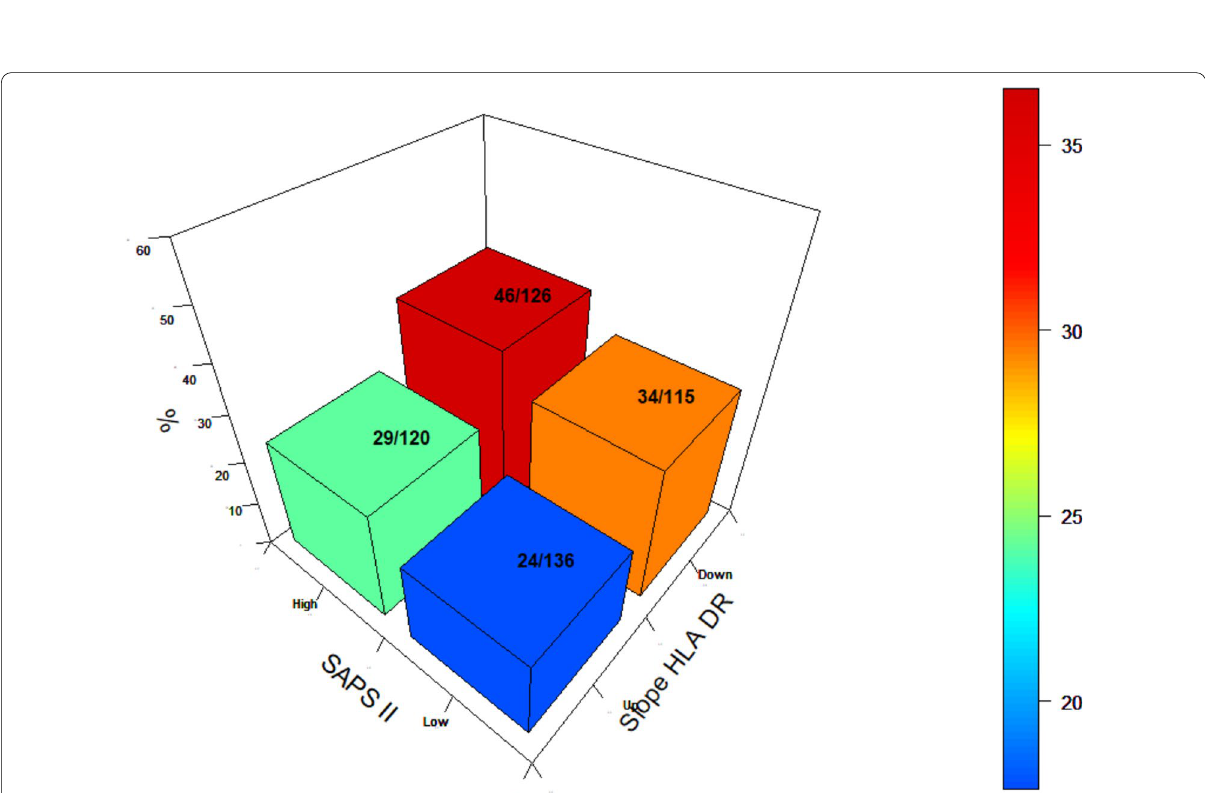
Fig. 3 Tridimensional representation of the relation between SAPS II—the slope of mHLA-DR and the occurrence of secondary infection at day 28. Figure represents patients dichotomized based on median SAPS II and mHLA-DR > or to 8000 AB/C. Whatever initial gravity, the existence of a ≤ decreasing slope between the first and second measurement of mHLA-DR is a strong risk factor for the later occurrence of ICU-acquired infection. SAPS II: Simplified Acute Physiology Score 2; mHLA-DR: monocytic human leukocyte antigen-antigen D